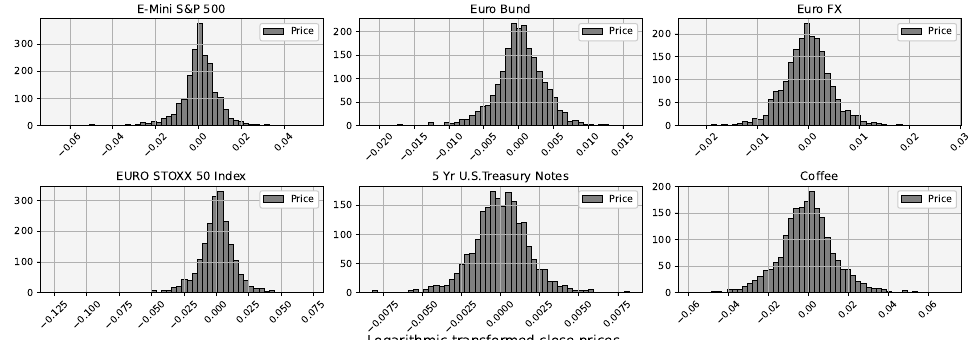
Figure 6. Distribution of selected futures logarithmic returns during 8 year period.